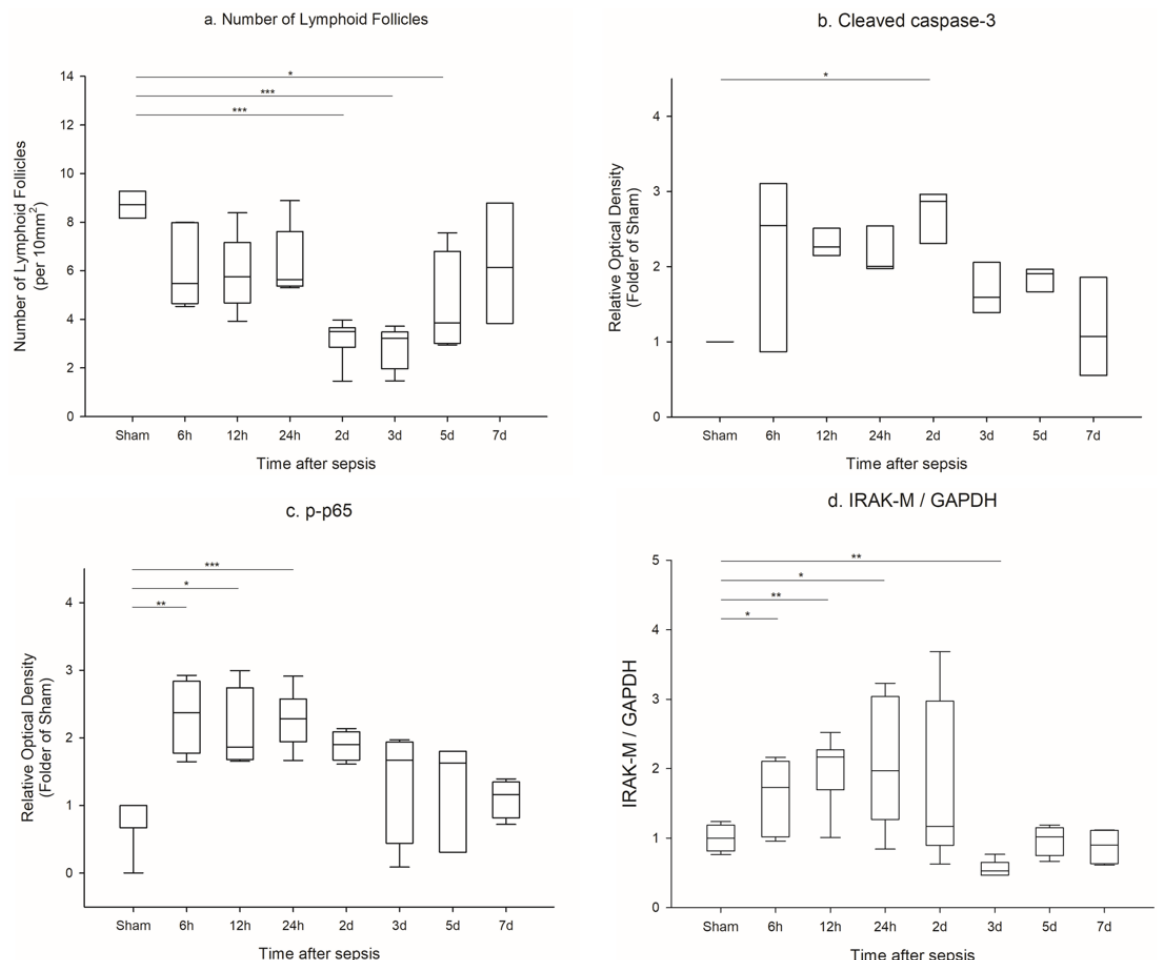
Figure 5. Serial change of pathology of spleen, apoptosis, NF ‐ kB, and IRAK ‐ M: ( a ) Pathologic changes in spleen, lymphoid follicles counted (sham and 7 D n = 3, 6 h, 12 h, and 2 D n = 6, 24 h, 3 D n = 5, and 5 D n = 4); ( b ) cleaved caspase 3 expression in spleen (n = 3 per group); ( c ) phosphorylated p65 in spleen (sham n = 7, 6 h, 12 h, 2 D, 3 D, and 7 D n = 4 per group, 24 h n = 6, and 5 D n = 3); ( d ) IRAK ‐ M in spleen (sham, 5 D, and 7 D, n = 4 per group, 6 h, 24 h, 2 D n = 8 per group, and 12 h, 3 D n = 6). The blots were cropped and full ‐ length blots are presented in supplementary files. The samples were derived from the same experiment. *** p < 0.001, ** p < 0.01, and * p < 0.05 compared with the sham group.